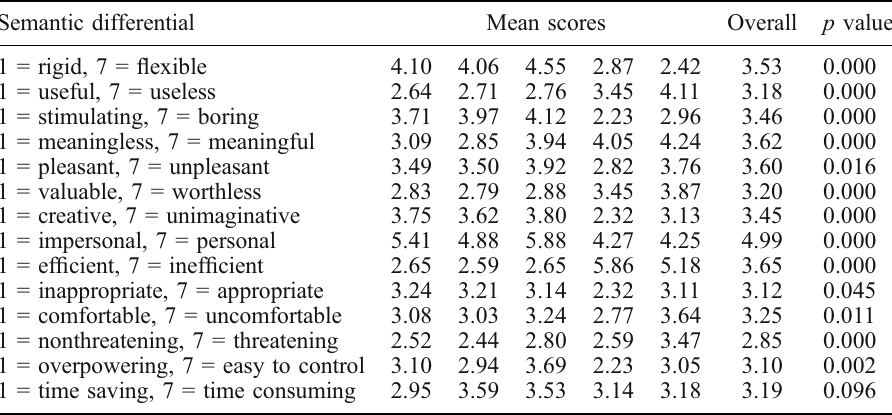
Table 6. Semantic differential differences between participants from different universities. Semantic